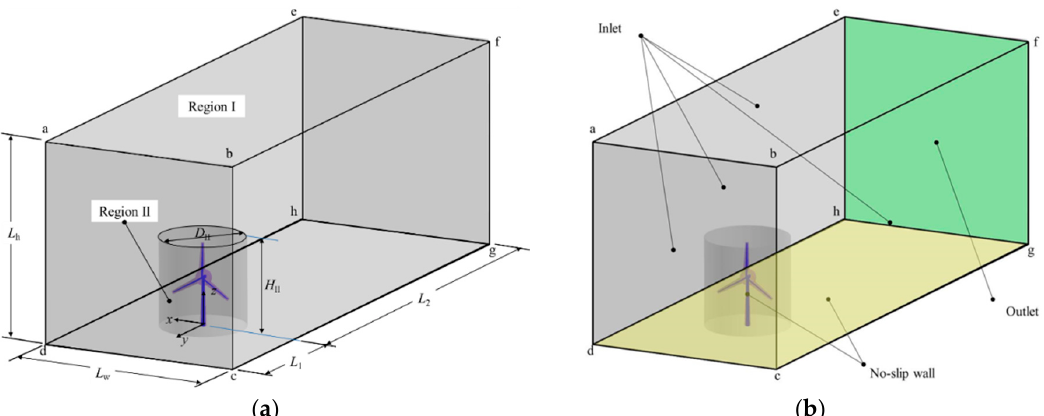
Figure 11. ( a ) Computational domain; ( b ) boundary conditions.